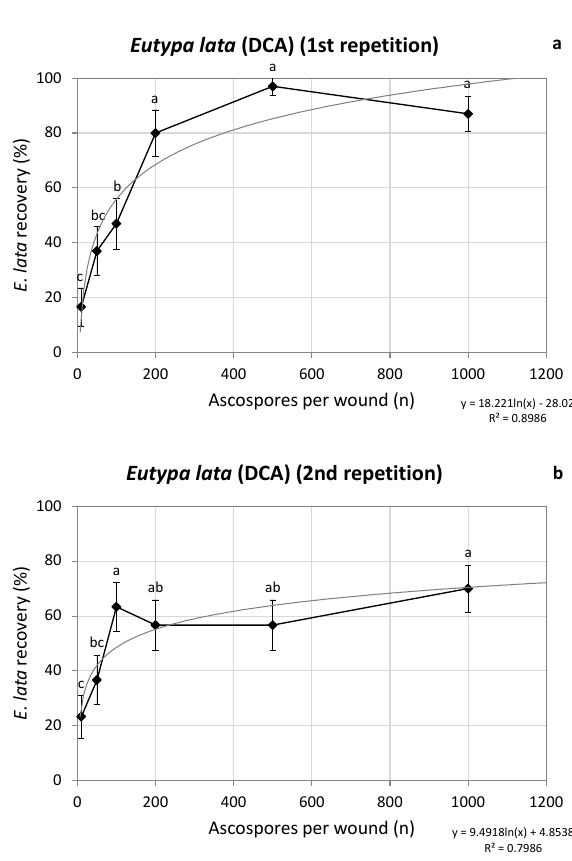
Figure 4. Mean percentage recovery from the two DCA experiments (cv. Cabernet Sauvignon) inoculated with Eu- typa lata . Thirty replications (canes) were used in each ex- periment for each inoculum dosage of 10, 50, 100, 200, 500 or 1000 ascospores/wound. Significant differences among means ( P <0.05) are indicated by different letters. Bars cor - respond to the standard error of the